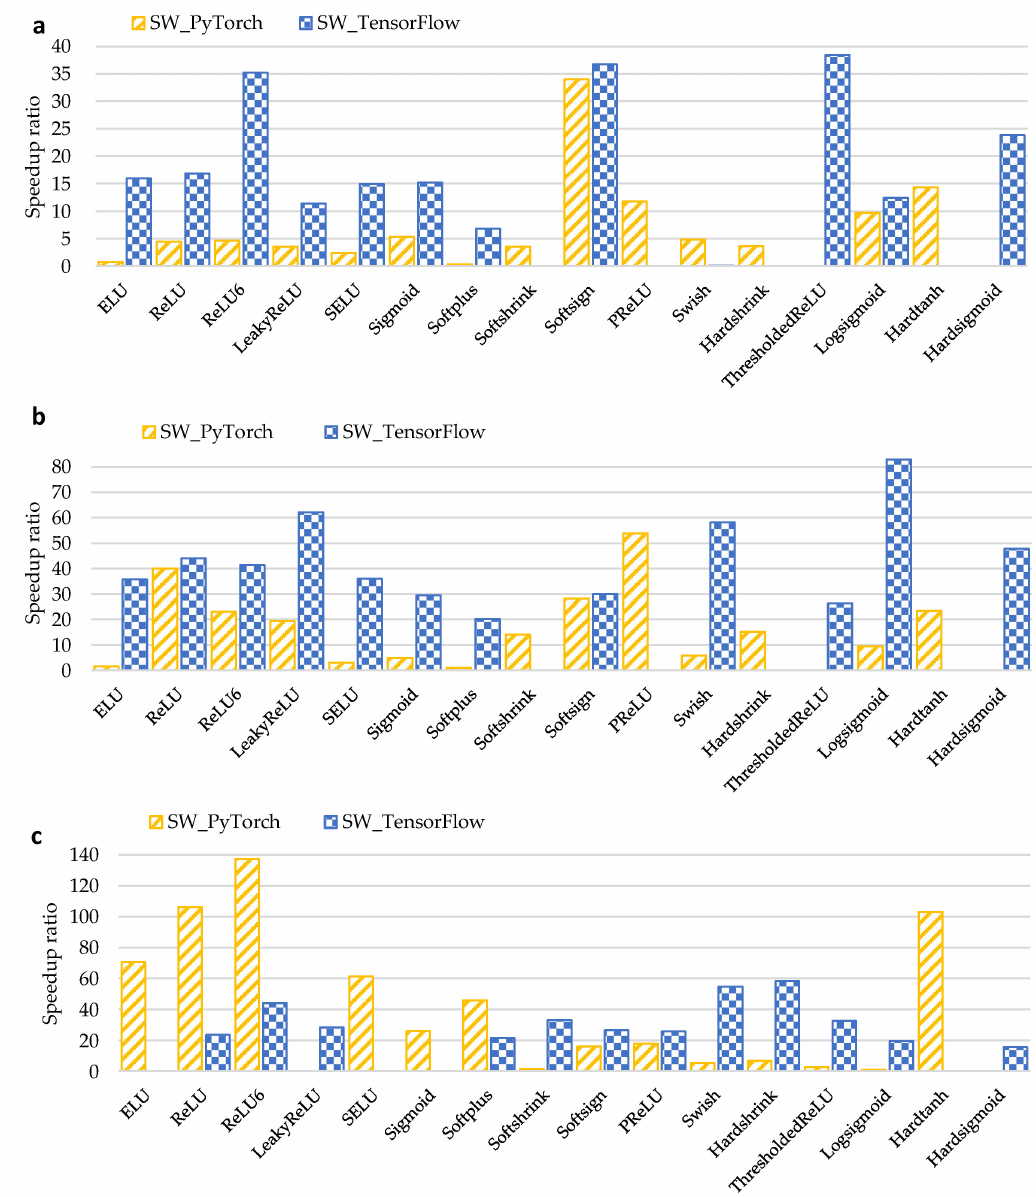
Figure 4. Performance benchmarking of the activation functions in the swAFL library. ( a ) Single- precision on the master core, ( b ) Single-precision on the slave core, and ( c ) Half-precision on the slave